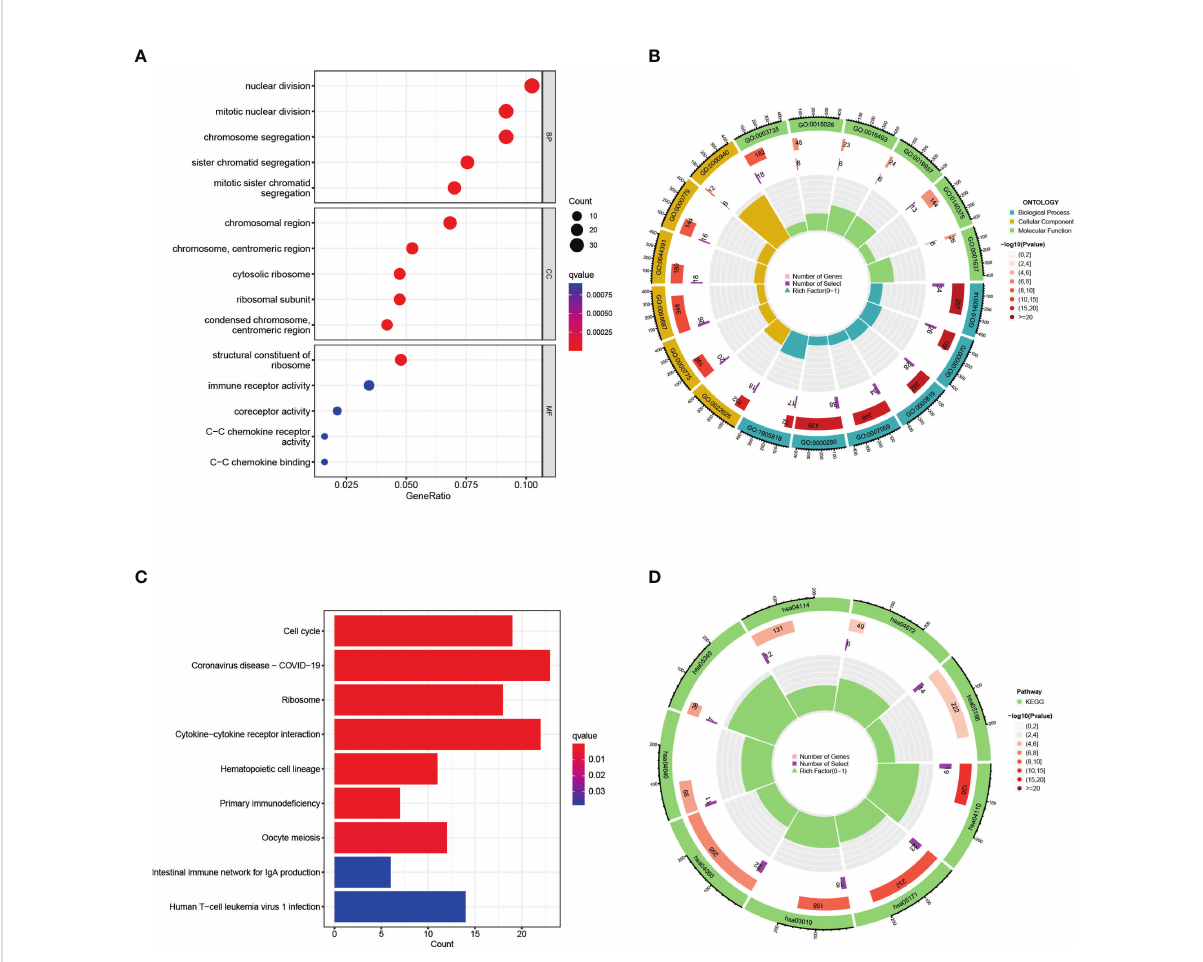
FIGURE 3 GO and KEGG functional enrichment analysis of the common differentially expressed genes between COVID-19 and HIV. (A) The bubble graphs of GO enrichment analysis. (B) Circle diagram of GO enrichment analysis. (C) The bar graphs of KEGG enrichment analysis. (D) Circle diagram of KEGG enrichment